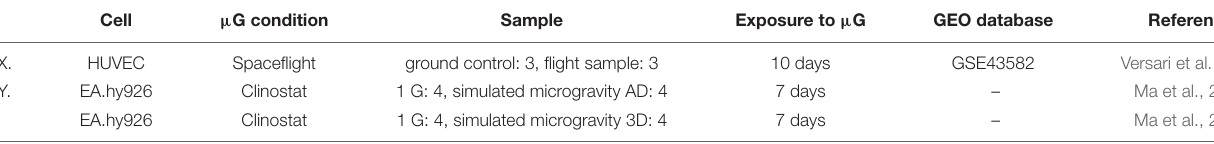
TABLE 1 | DNA array datasets used for meta-analysis in endothelial cells.